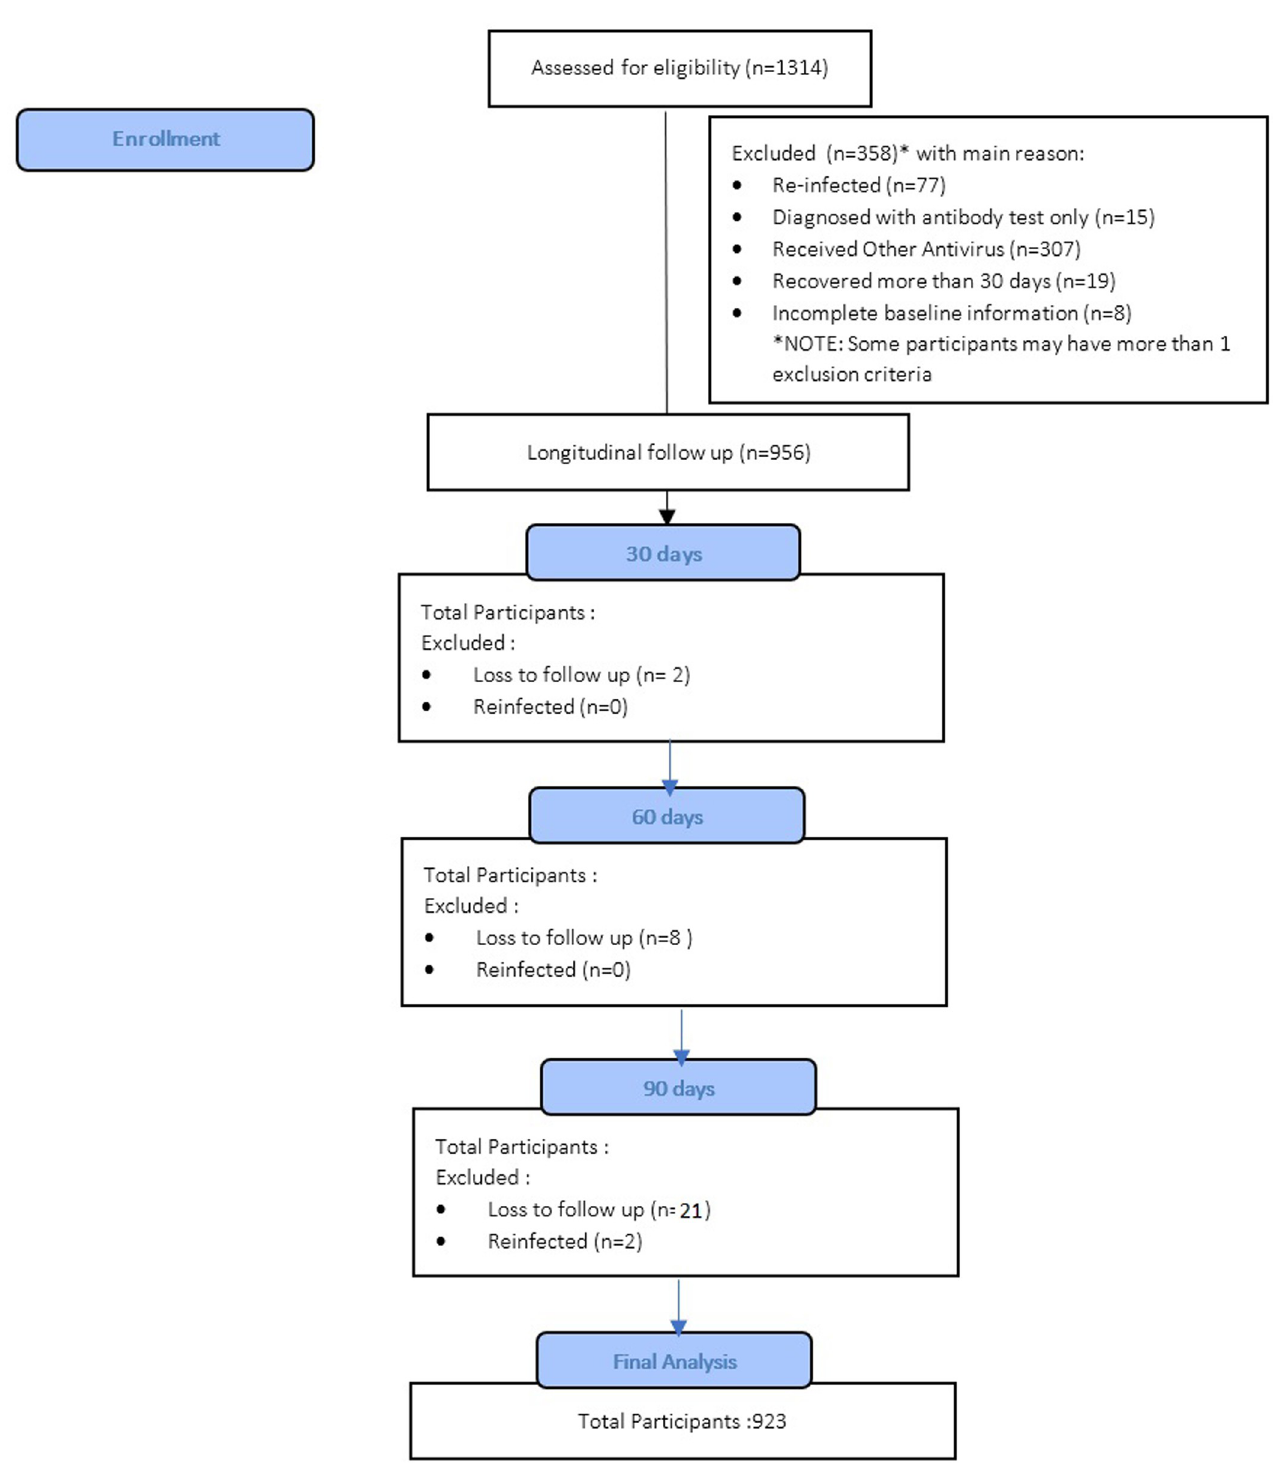
Fig 1. Flow diagram of the participant selection process (n =